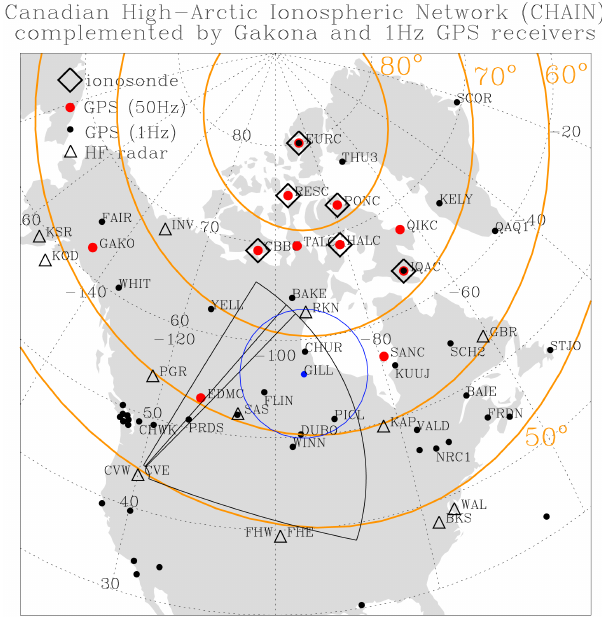
Figure 1. The GPS ionospheric scintillation and TEC monitors (red dots) complemented by geodetic-quality GPS receivers recording at sampling rate of 1Hz (black dots). Fields of view of an all-sky imager (ASI) in Gillam and the SuperDARN Christmas Valley East radar are shown, with radar beam 3 highlighted. Locations of Su- perDARN radars are indicated by triangles. The altitude-adjusted corrected geomagnetic (AACGM) latitudes 50, 60, 70, and 80 ◦ , in yellow, are superposed over the geographic